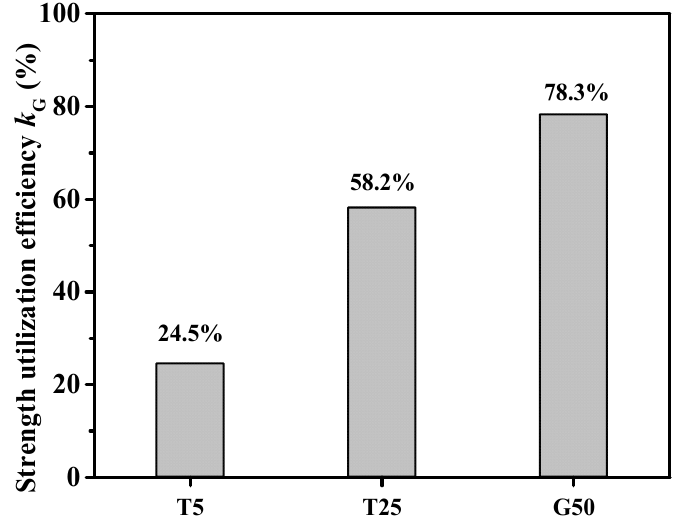
Figure 3. Strength utilization efficiency k G .